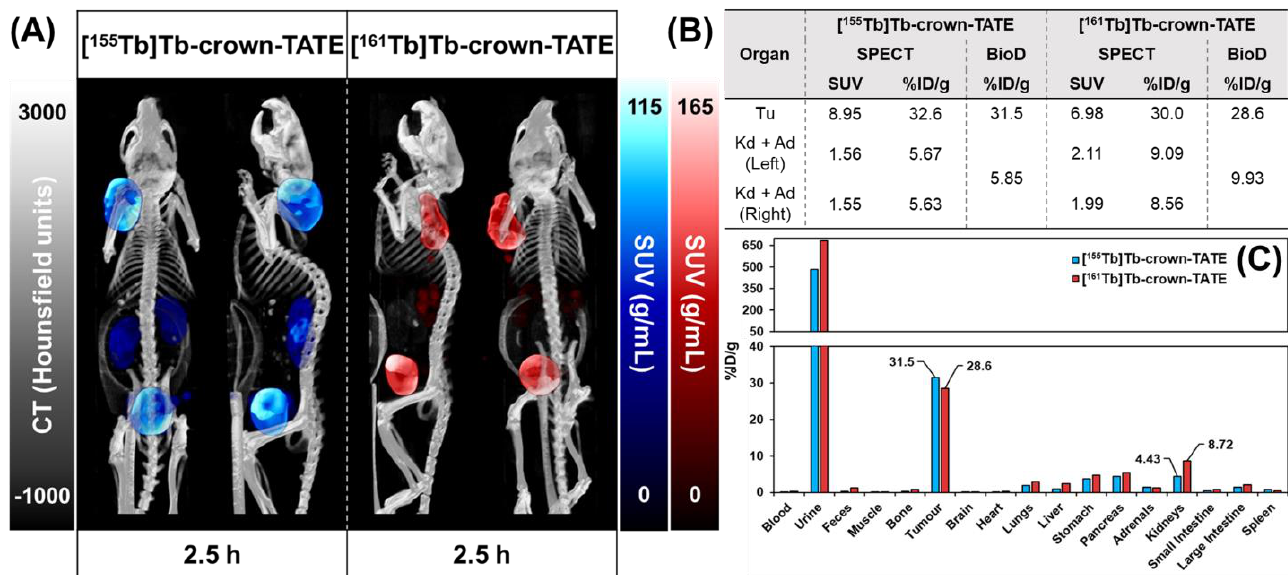
Figure 4. Summary of preclinical data for imaging mice bearing AR42J tumour xenografts at 2.5 h post-administration of [ 155 Tb]Tb-crown-TATE (13.8 MBq, 0.71 nmol) and [ 161 Tb]Tb-crown-TATE (7.95 MBq, 0.70 nmol). ( A ) Viewpoints of MIPs from quantitative static SPECT/CT. ( B ) Comparison